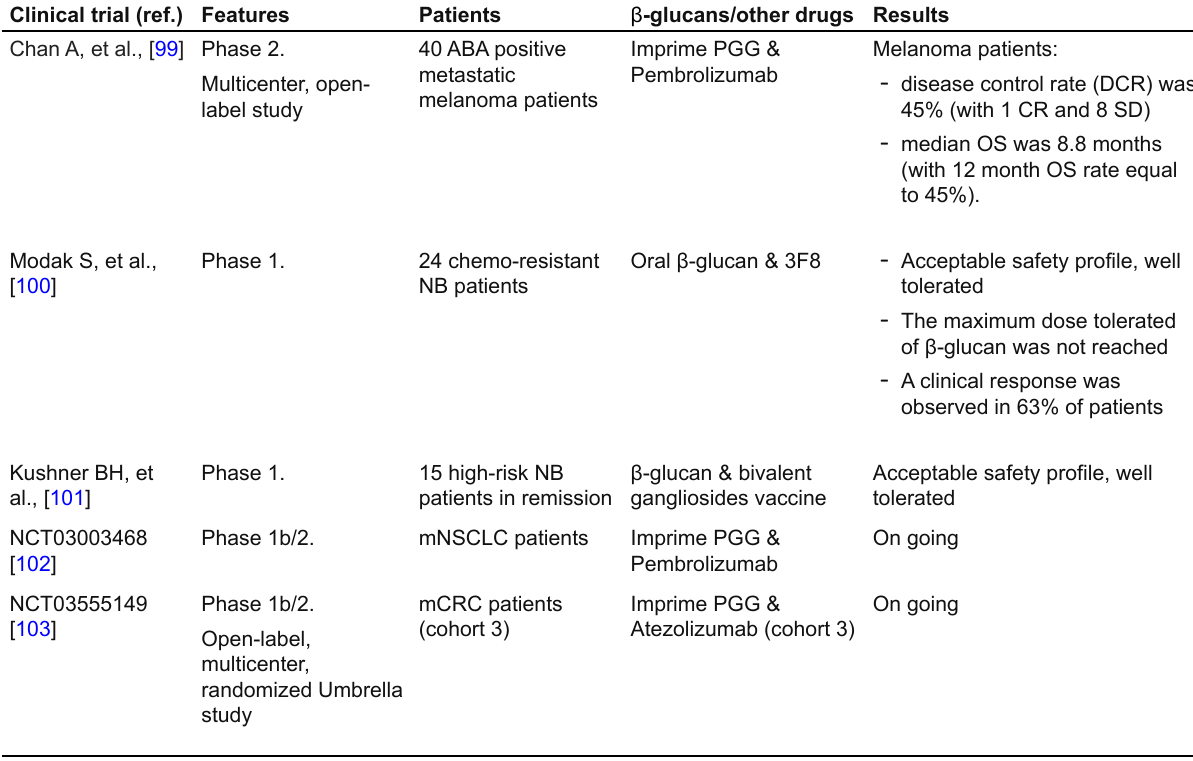
Table 2. Biological activity of most relevant β-glucans investigated in clinical studies ( continued ) Clinical trial (ref.)